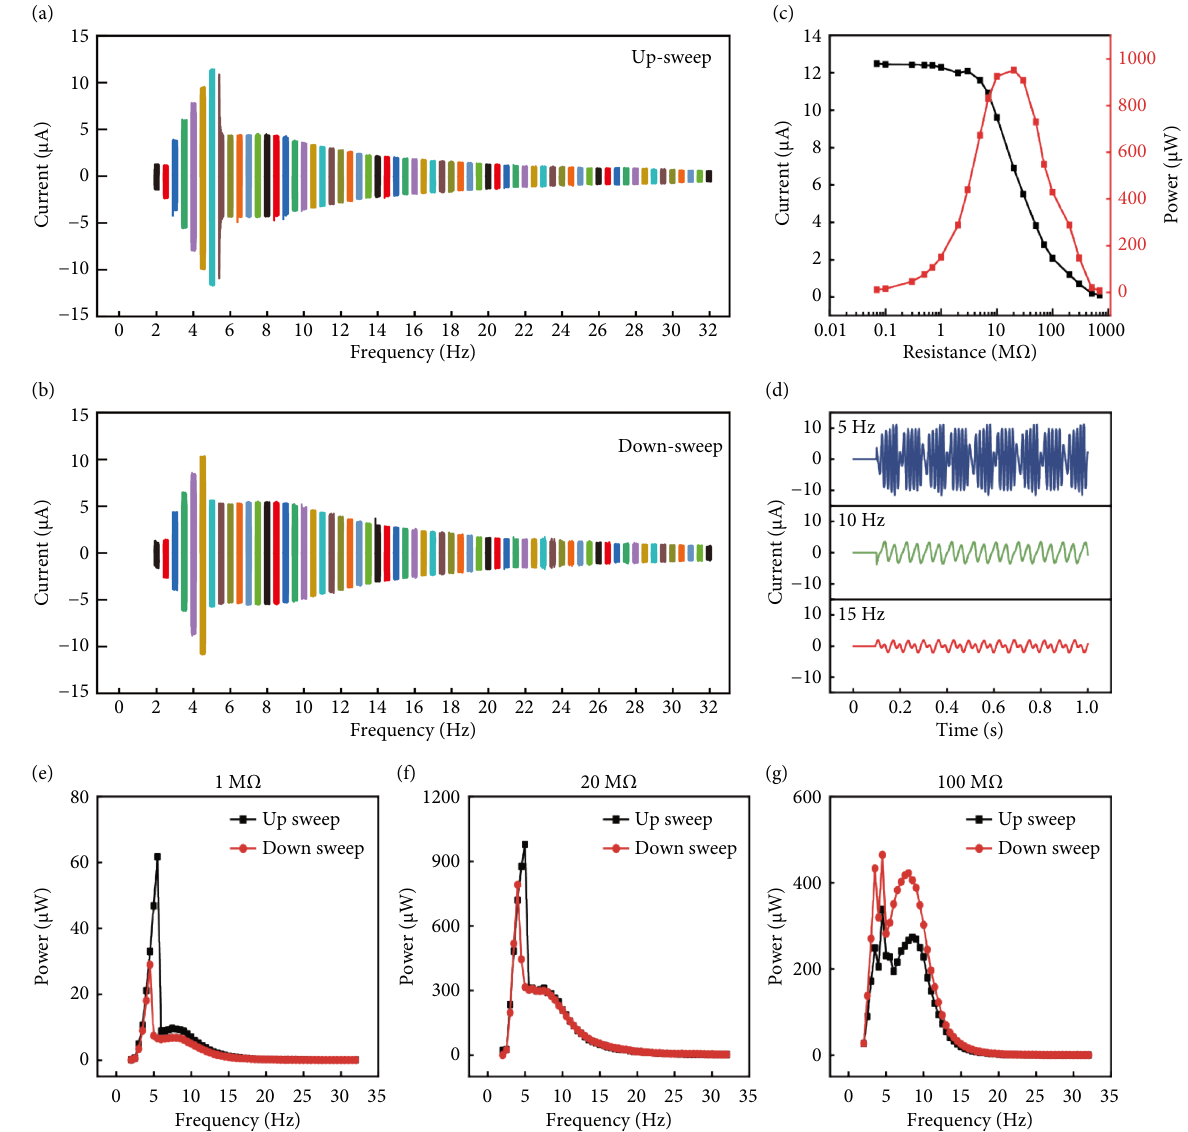
Fig. 2 Electrical output of NN-TENG. (a, b) Current under up-sweep and down-sweep, (c) current and power output under different resistance. (d) Typical current curve under 5 Hz, 10 Hz, and 15 Hz and (e–g) Peak power under 1 MΩ, 20 MΩ, and 100